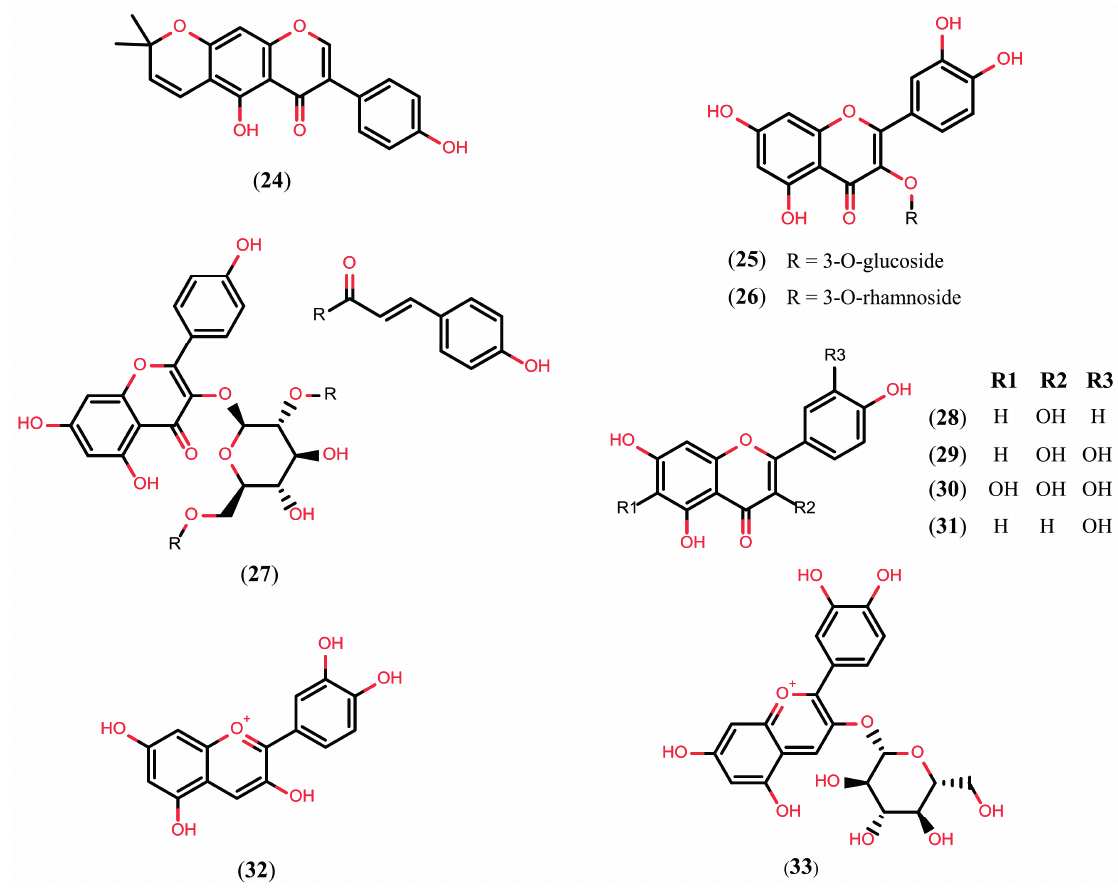
Figure 6. Chemical structures of flavonoids known to have schistosomicidal properties (compounds 24 – 28 ) and Sm NACE inhibitors (compounds 29 – 33